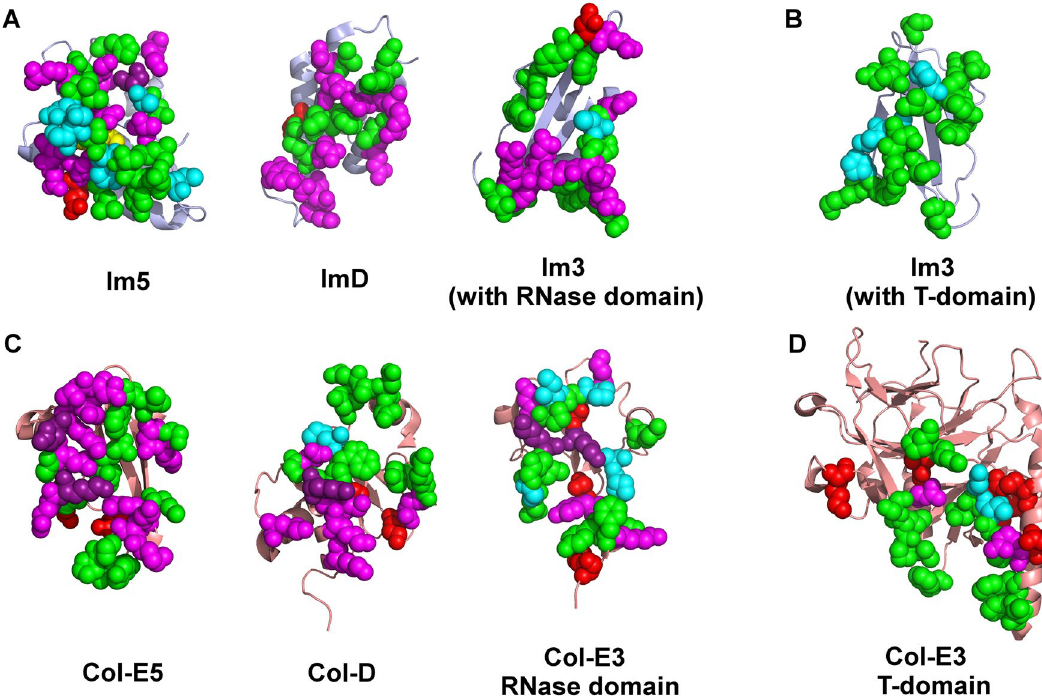
Figure 10. 3D visulization of residues that substantially contribute to interactions between colicins E5, D, E3 and their cognate immunity proteins. ( A ) Residues in Im5, ImD, and Im3 that substantially contribute to interactions with their cognate partners. The three interfaces correspond to immunity protein interactions with the cytotoxic domains of the cognate colicins, similar to the compelxes analyzed in Fig. 4. ( B ) Residues in Im3 that substantially contribute to interactions with the translocation domain (T-domain) of Col-E3. This domain was truncated in the other structures analyzed here. ( C ) Residues in colicins E5, D and E3 that substantially contribute to interactions with their cognate partners. Only the cytotoxic RNase domains are shown. ( D ) Residues in the T-domain of Col-E3 that substantially contribute to interactions with Im3. Immunity proteins and colicins/pyocins are shown as ribbons colored light blue and salmon, respectively. The results were visualized on the following structures: Col-E5–Im5 (2FHZ), Col-D–ImD (1V74), Col-E–Im3 (2B5U). All contributing residues are shown as spheres, colored as in Fig.